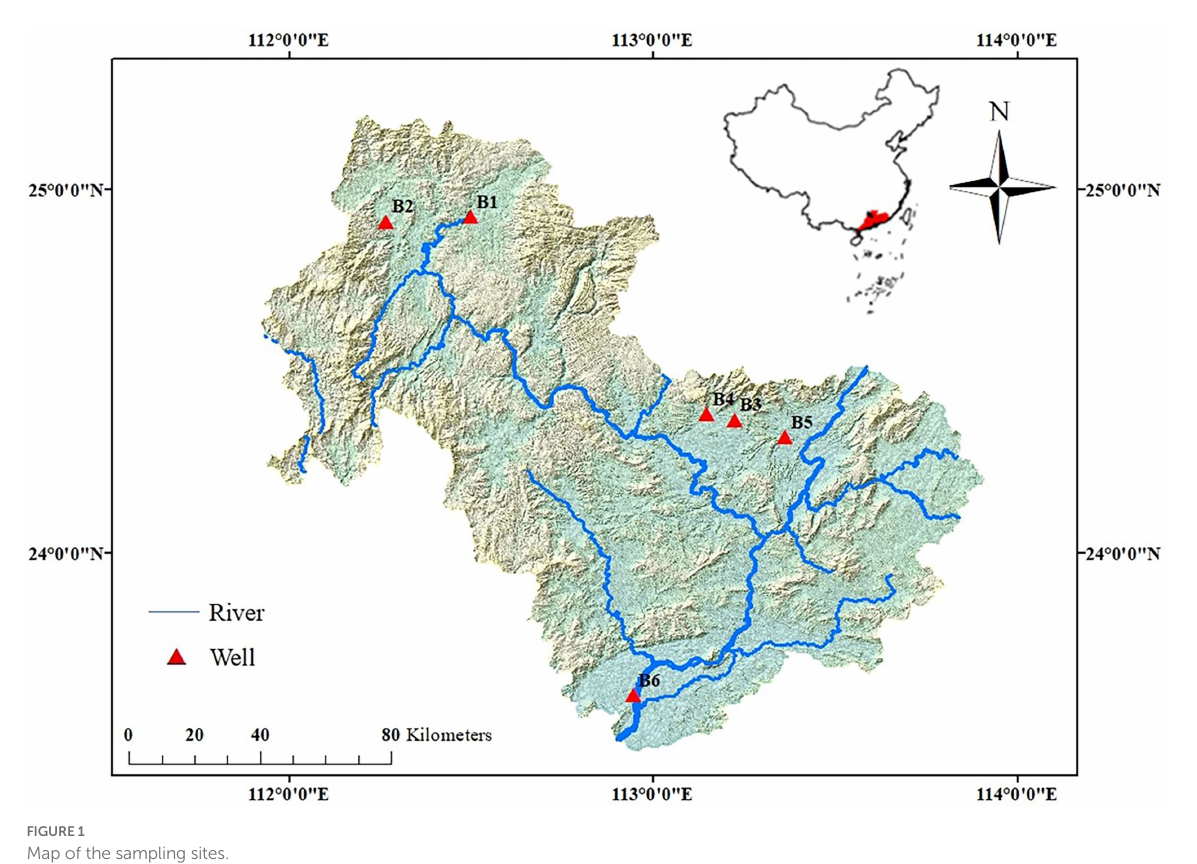
FIGURE 1 Map of the sampling